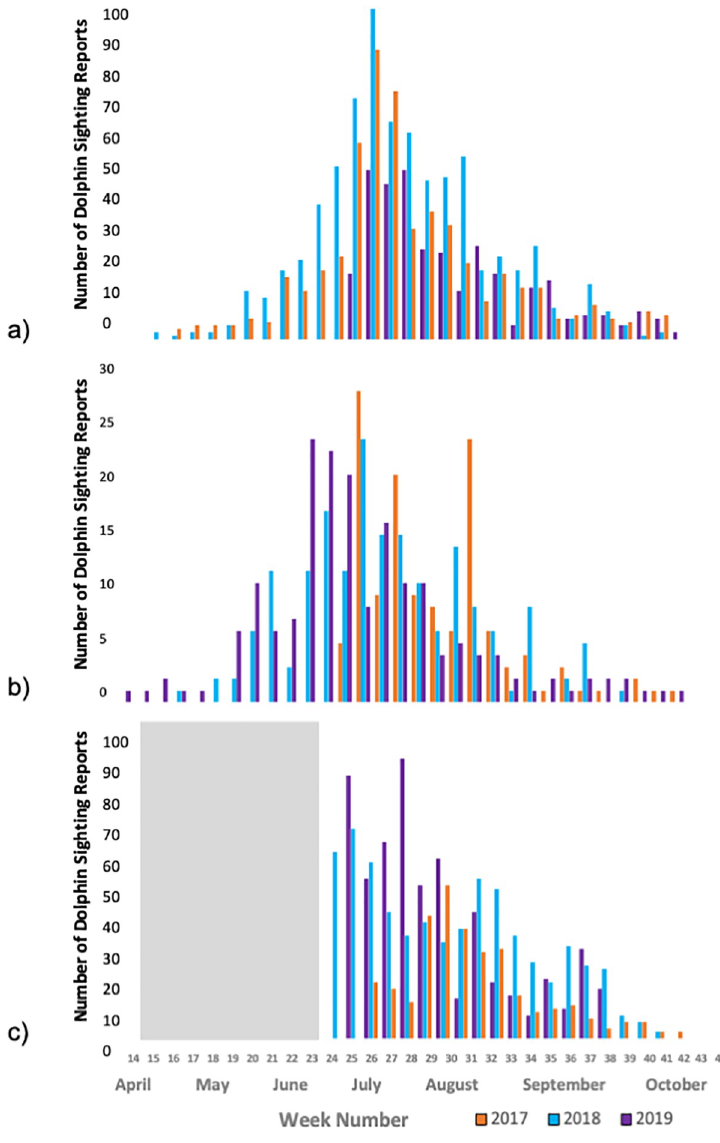
Fig 3. Temporal distribution of dolphin data. a) Weekly total of confirmed, non-duplicated Chesapeake DolphinWatch sighting reports across all segments of the Chesapeake Bay. b) Weekly total of confirmed Chesapeake DolphinWatch sighting reports in the Middle Bay segment of the Chesapeake Bay. c) Total sum of weekly acoustic detection positive hours (DPH) for the Middle Bay segment only, with the gray area indicating the absence of data. Map attribution: ESRI, HERE, Garmin, OpenStreet